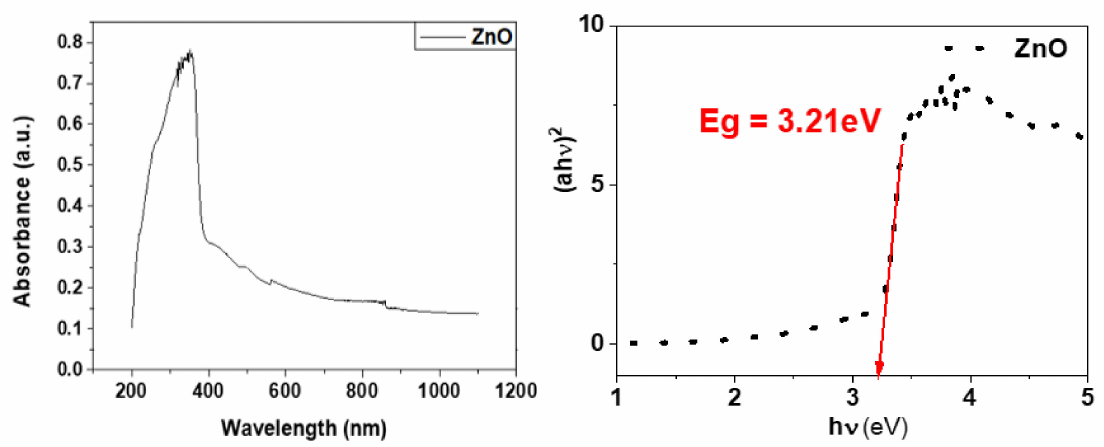
Figure 4. UV-vis Absorbance and Tauc’s plot of